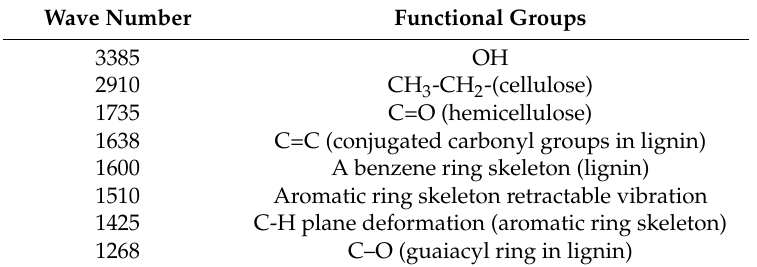
Figure 2. Fourier transform infrared spectroscopy (FTIR) spectra. ( a ) Untreated southern pine, ( b ) heat treated at 140 °C, ( c ) heat treated at 220 °C. Table 2. Main bands of infrared spectrum of wood and their assignment to functionality.